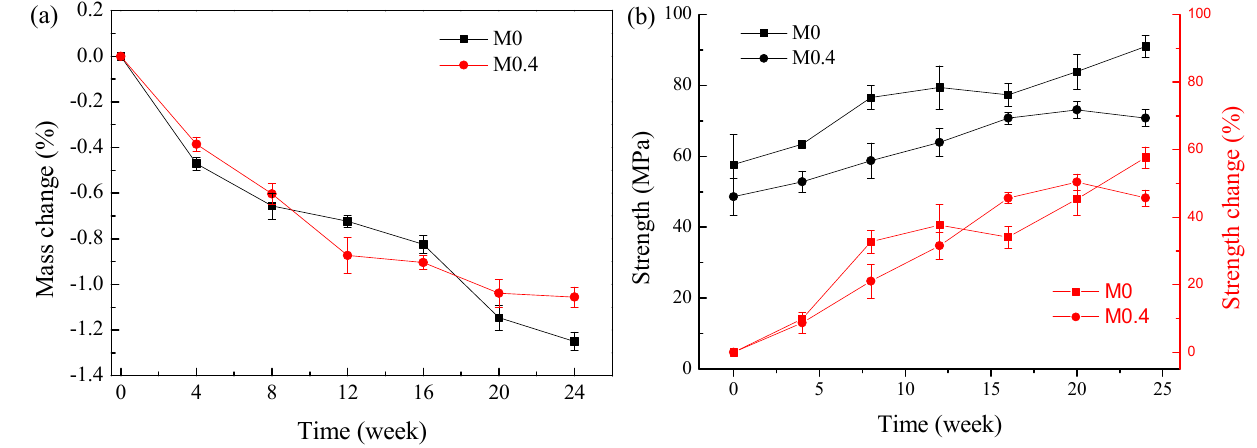
Figure 1. Mass and compressive strength changes at various times for AAMs in sodium sulfate solution. ( a ) Mass change; ( b ) compressive strength and compressive strength change. The pregnant sulfate solution was analyzed using ICP-OES and the concentrations of Na, Ca, Al, and Si in the solution are summarized in Table 2. Fe and Mg cannot be detected as Fe and Mg precipitate in high basic solutions. Na, Al, and Si leached more significant from the beginning, and gradually leached less over the exposure time. The leaching behavior of Ca was different. The concentration of Ca gradually increased and the highest concentration was recorded in the last cycle from week 20 to week 24. The initial weight ratio in CaO between M0.4 and M0 was 0.62 (6.5/10.5). The Ca weight ratio in the pregnant solution ranged from 0.262 to 0.506 and increased with time. Even relative to the chemical composition, more Ca leached out from M0 during the 24-week exposure to the Na 2 SO 4 solution. More Al and Si leached from the M0–AAM in the first 8 weeks, and later on, the concentrations in the leachate from the M0.4–AAM were slightly higher. Table 2. Elements concentration of AAMs in sodium sulfate solution for certain ages (ppm) (deviation inside the bracket). M0-AAM